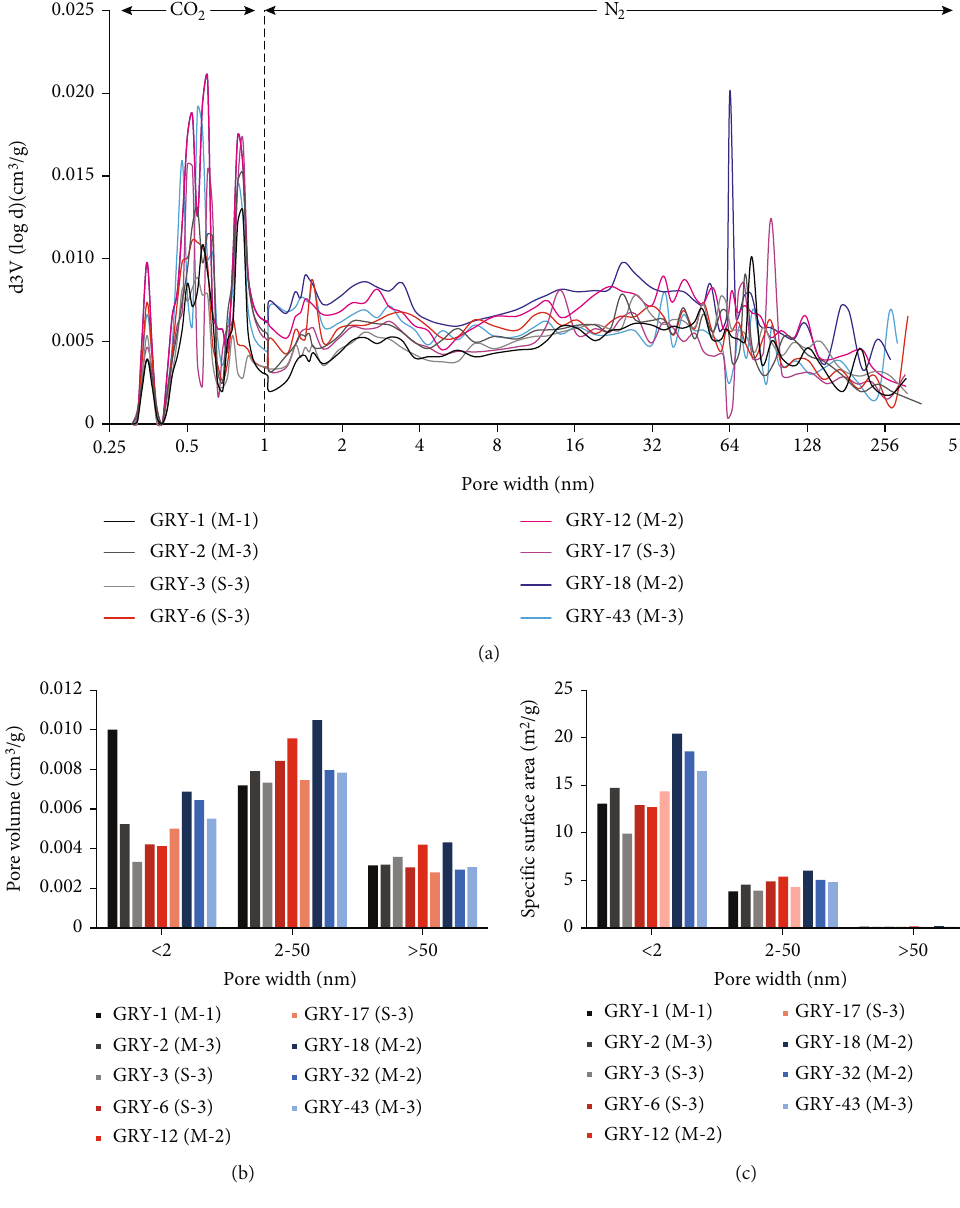
Figure 7: (a) N and CO pore diameter adsorption curve of Carboniferous shale samples in well GRY1; (b) pore volume distribution of 2 2 Carboniferous shale samples in well GRY1; (c) pore speci fi c surface area of Carboniferous shale samples in well